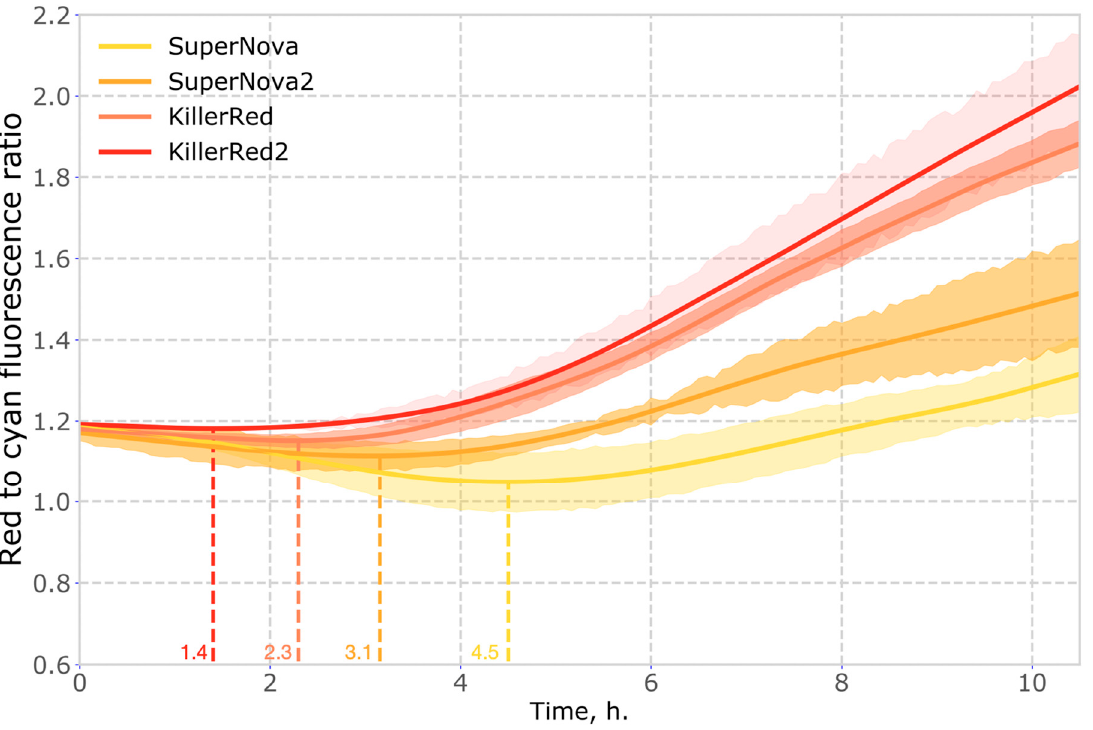
Figure 5. Time evolution of red to cyan fluorescence ratio in mammalian cells coexpressing red phototoxic proteins and mTurquoise2. Time corresponding to the extremum of the curve (when the rate of accumulation of red fluorescence exceeds that of cyan fluorescence) is shown on the X axis in colour.